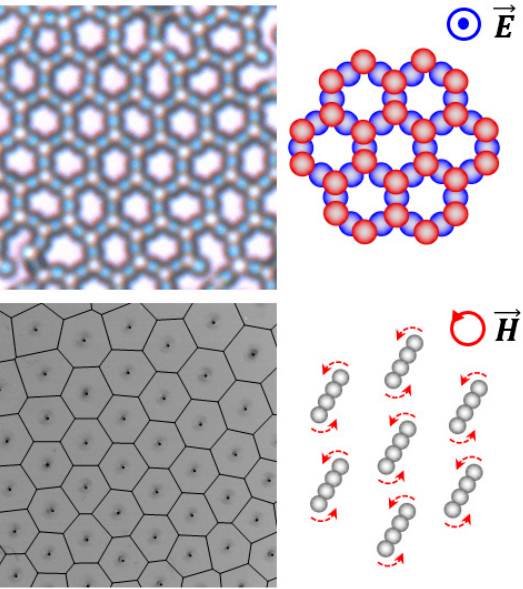
Figure 1. Dynamic structuring of hierarchically ordered structures. ( Top ) Honeycomb-like open structure emergent in a vertical electric field. In the schematic on the right side, the circle and dot with the electric field denote that the field is applied perpendicular to the plane of view. Reproduced with permission [20]. Copyright 2013, American Chemical Society. ( Bottom ) Hexagonal lattice structure emergent in an external in-plane rotating magnetic field. In the schematic on the right side, the dotted red arrows indicate the rotational direction of the multi-particle chains in response to the rotating field. Reproduced with permission [21]. Copyright 2020, American Association for the Advancement of Science.